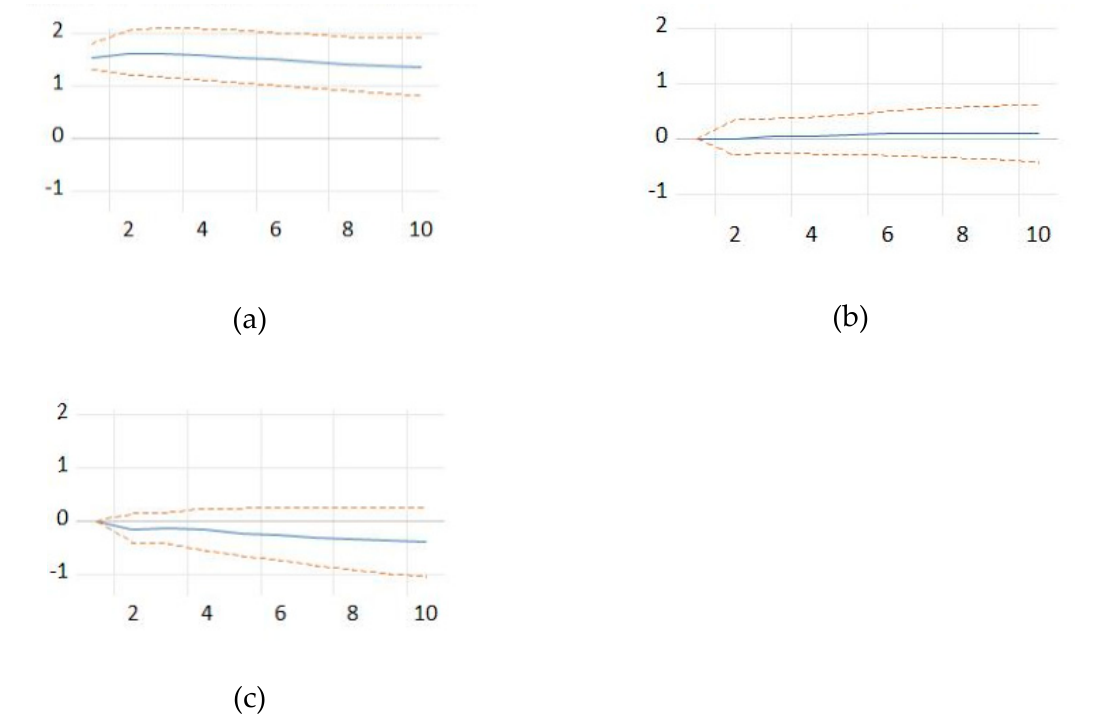
Figure 4. Response of GDP per capita to a shock from: ( a ) GDP per capita; ( b ) persons employed in the population of active enterprises; and ( c ) persons employed in the population of births. Source: the authors’ own computations.